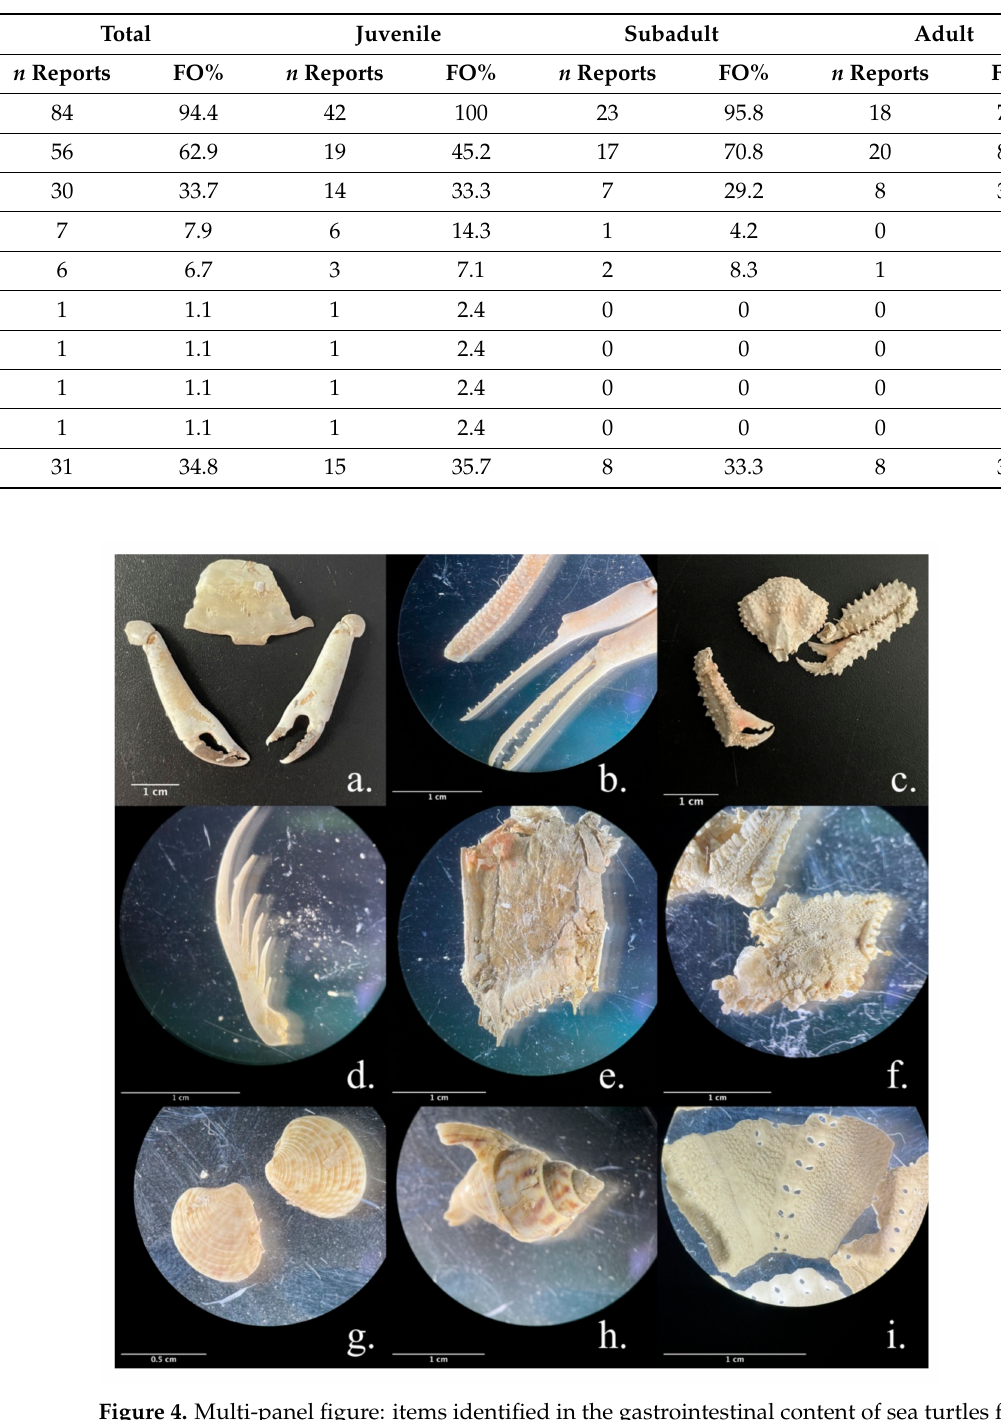
Figure 4. Multi-panel figure: items identified in the gastrointestinal content of sea turtles from the Adriatic Sea. ( a ) Goneplax rhomboides ; ( b ) Ilia nucleus ; ( c ) Parthenope anguilifrons ; ( d ) Squilla mantis ’ chela; ( e ) Squilla mantis ’ tail; ( f ) starfish; ( g ) Chamelea gallina (Striped venus); ( h ) Tritia mutabilis ; ( i ) Heart sea